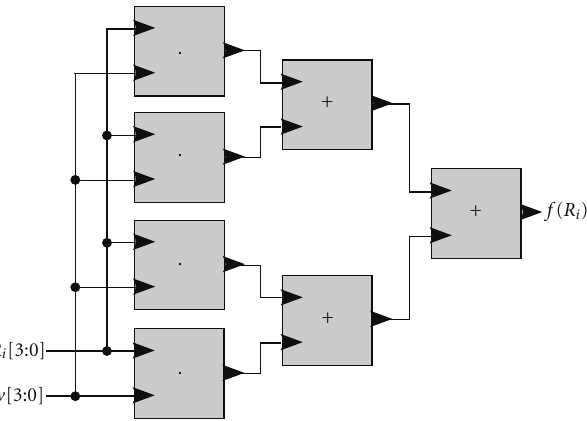
Figure 2: RIVYERA S3-5000. The 16 FPGA-cards forming the FPGA-computer are highlighted. The integrated standard PC cannot be seen behind the cover.